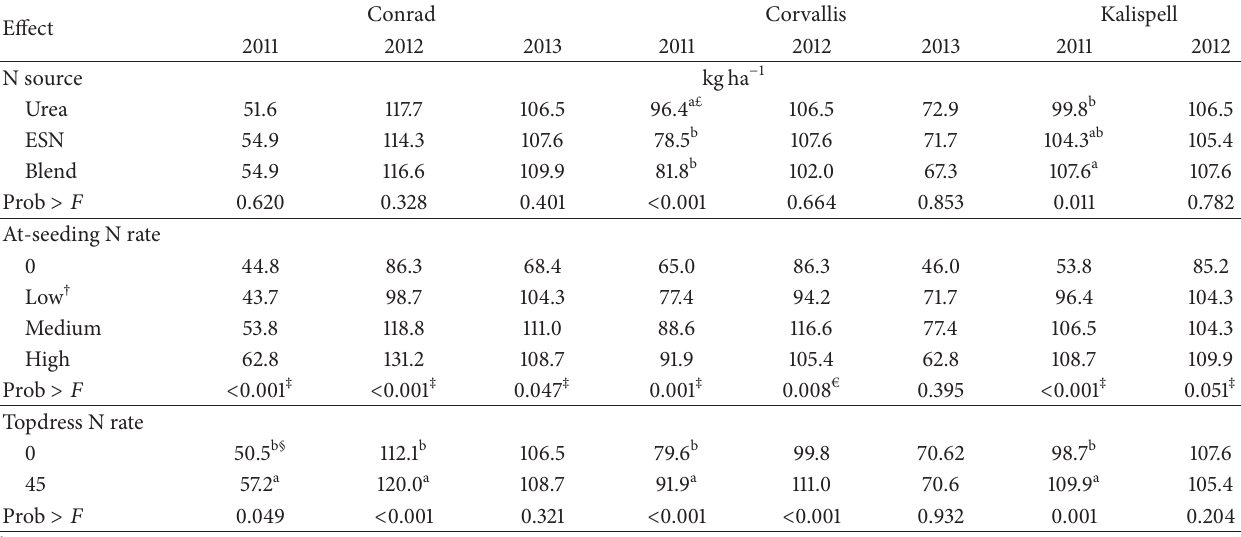
Table 6: Effect of at N source, preplant and topdress N rate on spring wheat grain uptake Conrad, Corvallis and Kalispell, 2011–2013 growing seasons.